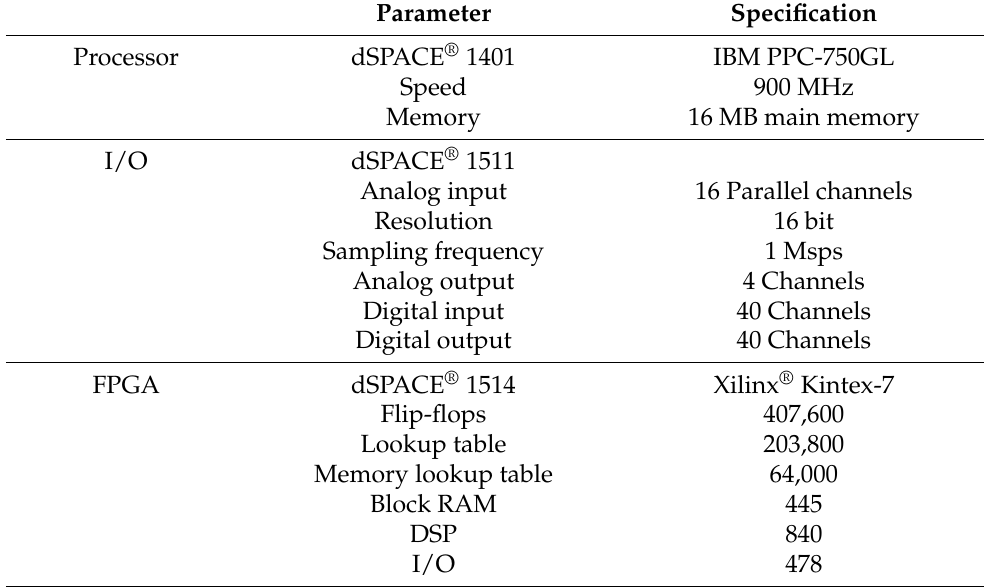
Figure 6. Schematic of experimental setup of the diesel engine in this work. Table 1. Rapid prototyping ECU